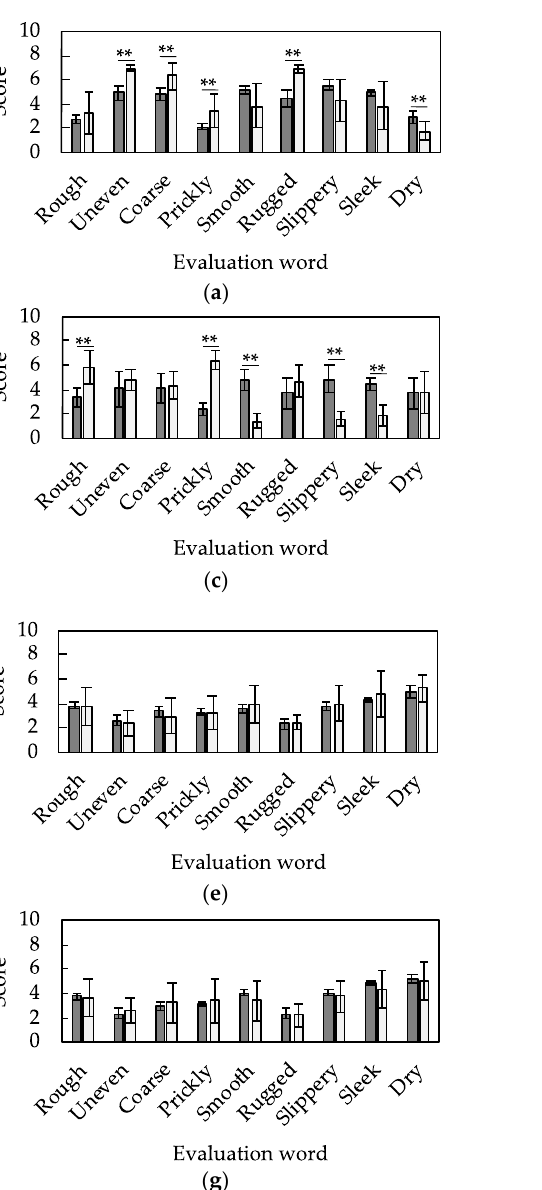
Figure 8. Comparison of the mean and standard deviation of the tactile scores estimated by the estimation model (gray, n = 3610, mean ± SD ) and the evaluation values obtained in the sensory evaluations by human participants (white, n = 14, mean ± SD ) for the nine evaluation words in each sample. Each panel is the result for a model that estimates the tactile sensation of ( a ) sample 1, ( b ) sample 2, ( c ) sample 3, ( d ) sample 4, ( e ) sample 5, ( f ) sample 6, and ( g ) sample 7 ( 𝑝 ∗∗ < 0.01 ).